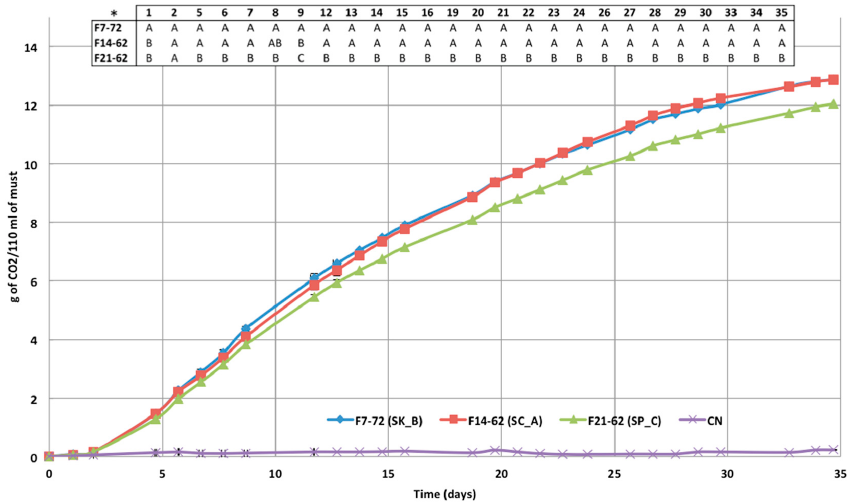
Figure 2. CO 2 escape during fermentation of tyndallized Fiano must by S. kudriavzevii (F7 ‐ 72), S. cerevisiae (F14 ‐ 62), and S. paradoxus (F21 ‐ 62). Data are mean values (n = 3) ± SD. * Different letters for each sampling point indicates significant differences (ANOVA: Tukey t ‐ test. p < 0.05—XLStat).